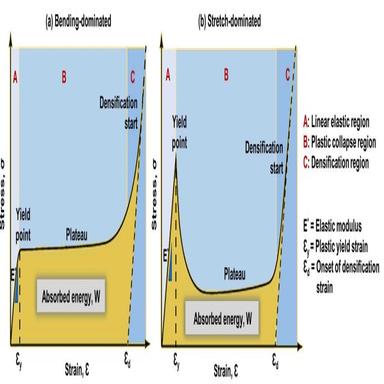
Theoretical stress–strain diagram of cellular lattice structures: (a) bending-dominated and (b) stretch-dominated. The figure was adapted from the work of Ashby .